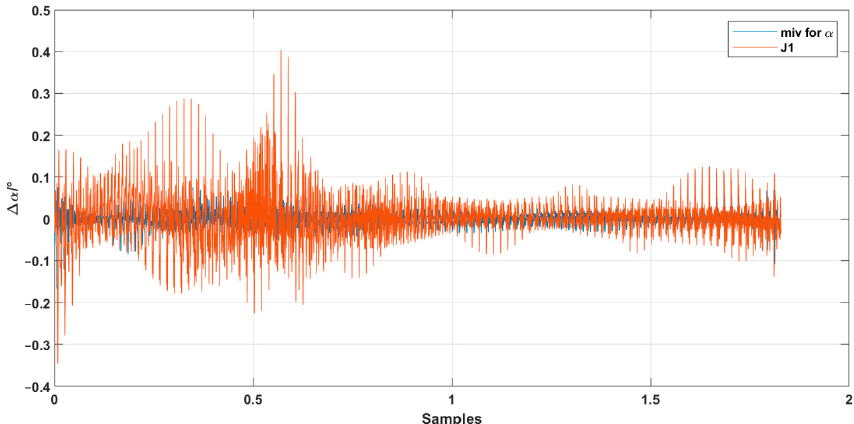
Figure 1. The illustration of the candidate locations. Table 1. The comparisons of the prediction error.